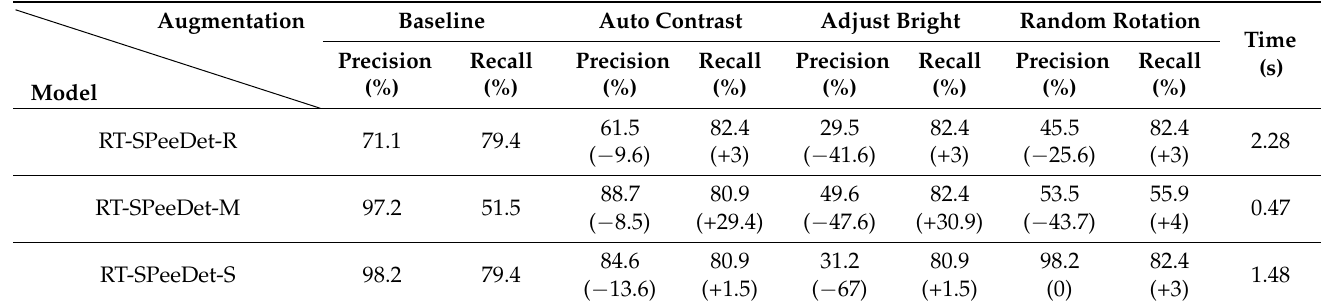
Table 5. Pit defect detection results according to the data augmentation techniques applied. Augmentation Model